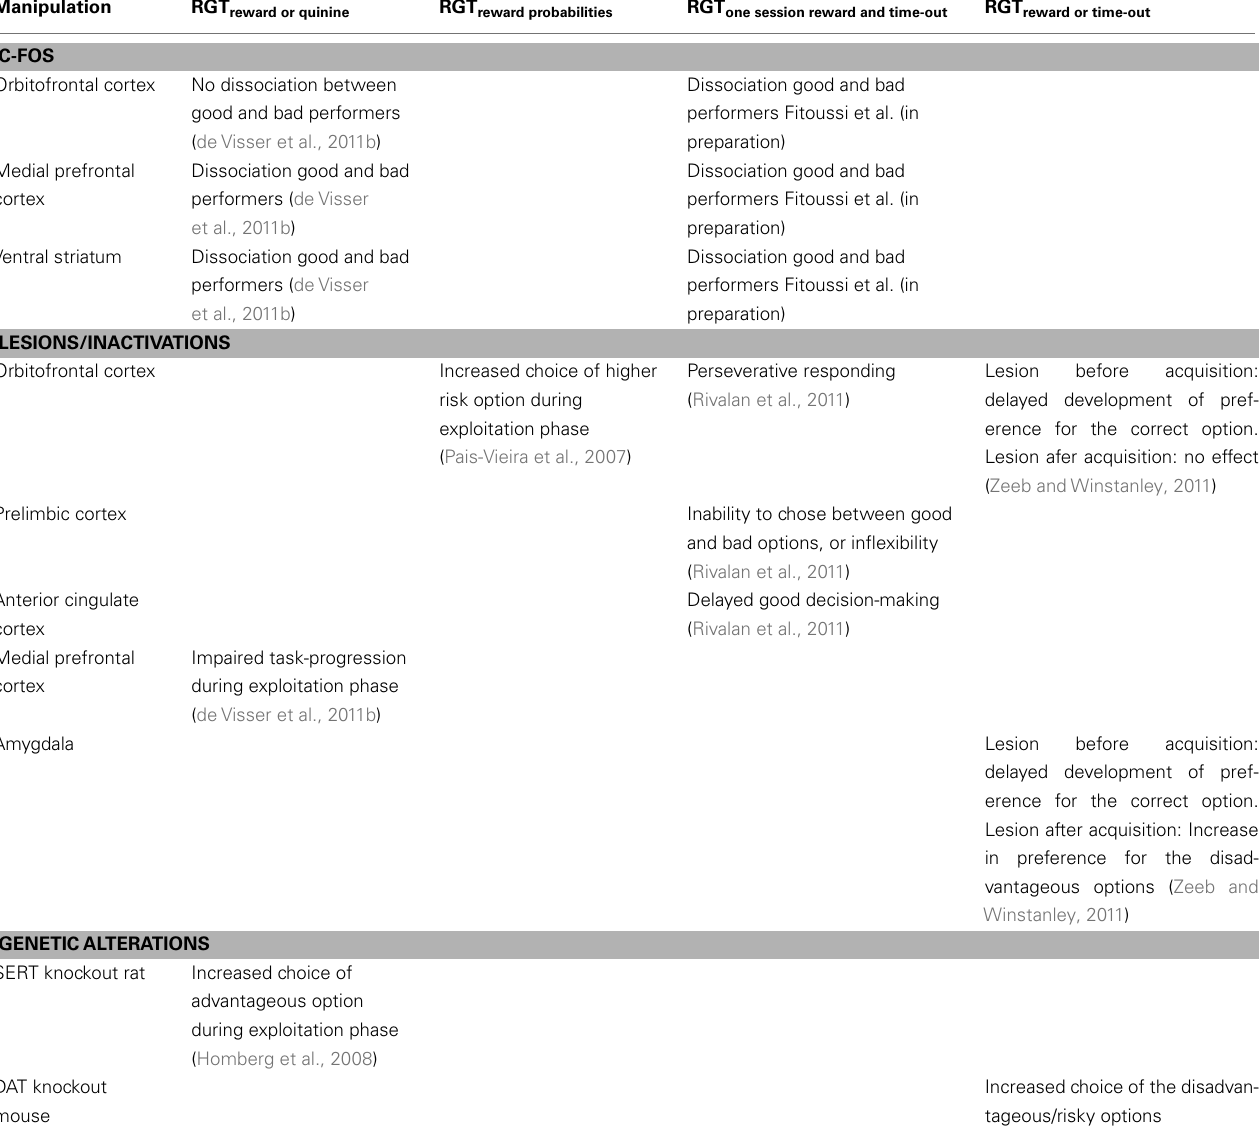
Table 2 | Effect of manipulations on rodent IGT